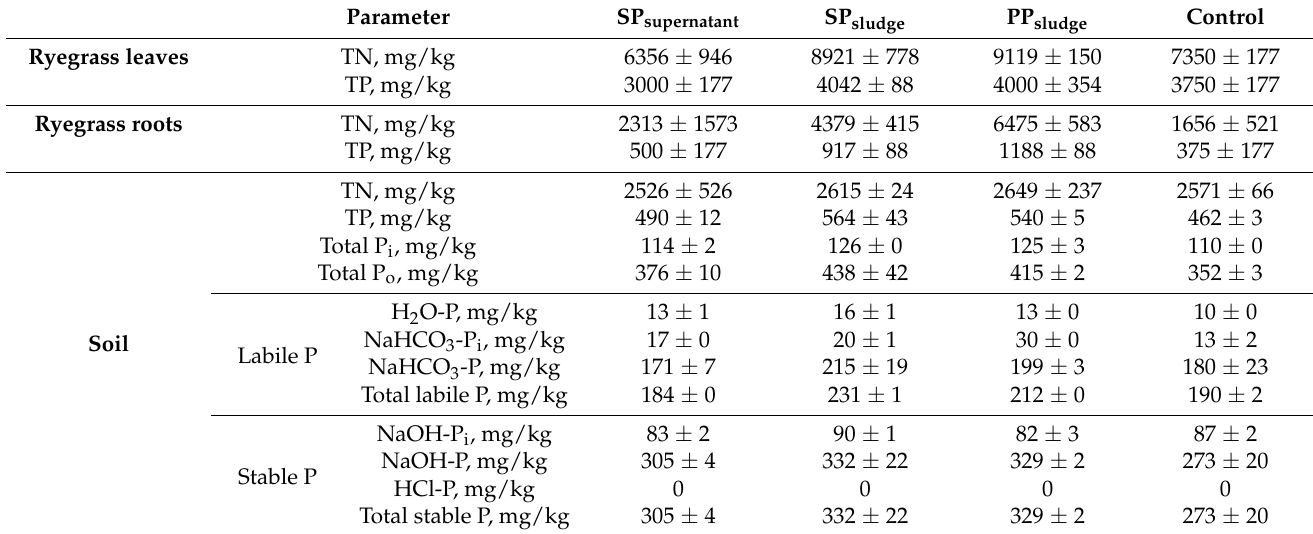
Table 7. Phosphorus and nitrogen in soil, ryegrass leaves and roots after dismantling